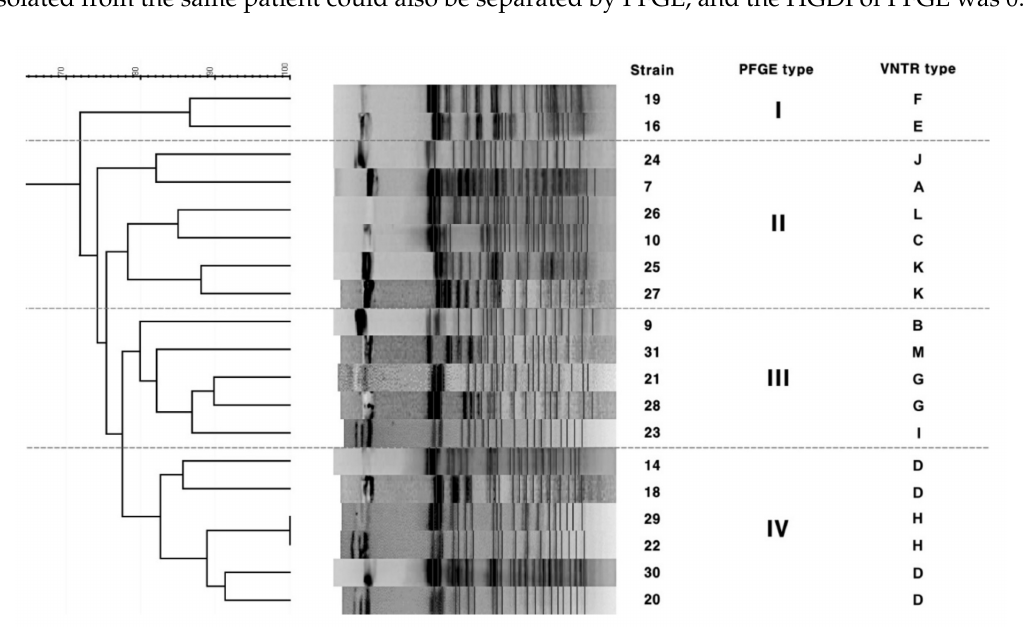
Figure 2. Dendrogram of the cluster analysis based on pulse field gel electrophoresis patterns of 19 M. intracellulare clinical isolates using